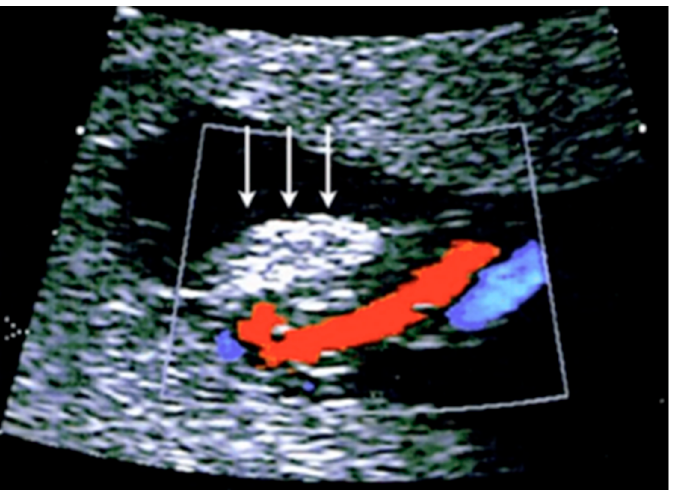
Figure 28. Transient umbilical cord hematoma in the cord insertion area on the placenta after intra uterine fetal transfusion (IUFT). Note the absence of blood flow on color Doppler ultrasound assessment (arrows).